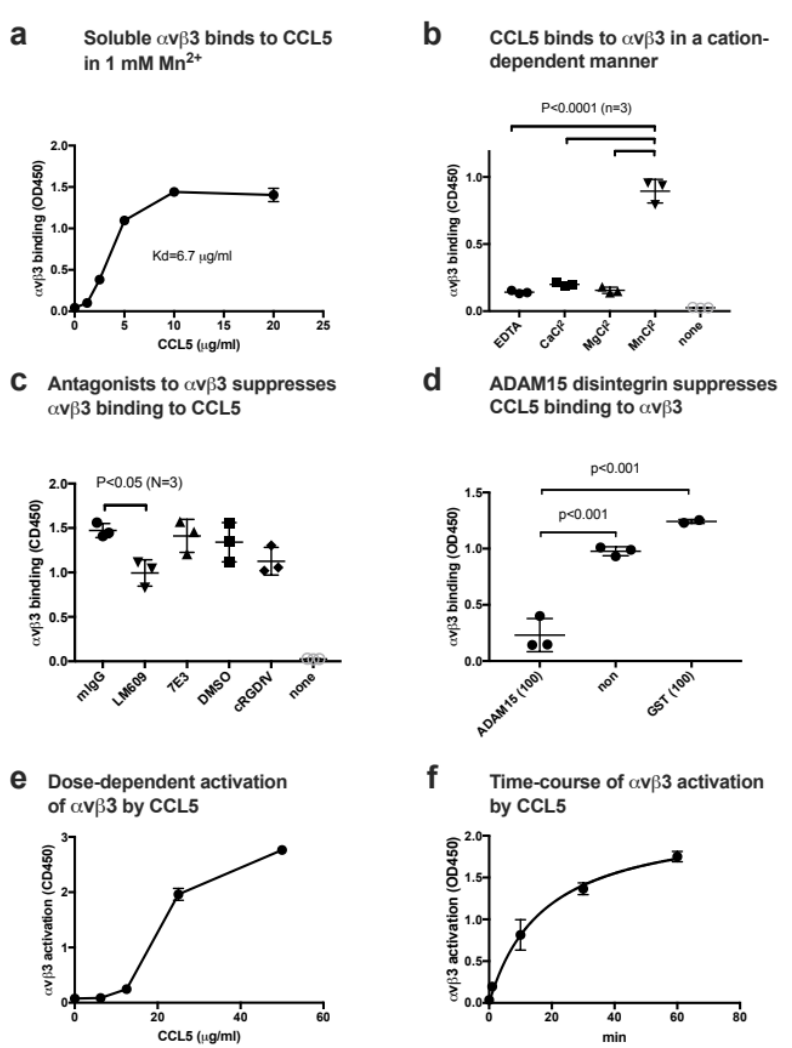
Figure 2. CCL5 binds to and activates integrin αvβ3. ( a ) Binding of soluble integrin αvβ3 to CCL5 in 1 mM Mn 2+ in cell-free conditions. Wells of 96-well microtiter plates were coated with CCL5 and remaining protein- binding sites were blocked with BSA. Wells were incubated with soluble αvβ3 (1 μg/mL) in Tyrode -HEPES buffer with 1 mM Mn 2+ (to activate αvβ3) for 1 h at room temperature. After washing the wells to remove unbound integrin, bound αvβ3 was quantifie d using anti- β3 mAb (AV10) and HRP- conjugated anti mouse IgG. Data are shown as means +/− SD in triplicate experiments. ( b ) Cation dependency of αvβ3 binding to CCL5. Binding of soluble integrin αvβ3 to CCL5 was measured in the presence of different cations (1 mM) in ELISA-type binding assays. Data are shown as means +/− SD in triplicate experiments. ( c ) Effect of antagonists to αvβ3 on CCL5 bind- ing to αvβ3. The concentrations of antagonists used are 10 μg/mL for LM609 and 7E3, and 10 μM for cRGDfV. Data ar e shown as means +/− SD in triplicate experiments. ( d ) ADAM15 disintegrin, a specific ligand for αvβ3, suppresses CCL5 binding to αvβ3. ADAM15 disintegrin fused to GST or control GST (100 µg/mL each) were included in the binding assay as described in (a). Data are shown as means +/− SD in triplicate experiments. ( e ) Activation of soluble αvβ3 by CCL5 in 1 mM Ca 2+ . Wells of 96- well microtiter plates were coated with γC399tr, a specific αvβ3 - ligand (20 μg/mL) and remaining protein-binding sites were blocked w ith BSA. Wells were incubated with soluble αvβ3 (1 μg/mL) in Tyrode -HEPES buffer with 1 mM Ca 2+ for 1 h at room temperature in the presence of CCL5. After removing the unbound integrin, bound αvβ3 was quantified using anti - β3 mAb (AV10) and HRP-conjugated anti mouse IgG. Data are shown as means +/− SD in triplicate experiments. ( f ) Time- course of activation of soluble αvβ3 by CCL5. Wells of 96 -well microtiter plates were coated with γC399tr (a specific ligand for αvβ3) (20 μg/mL) and remaining protein -binding sites were blocked with BSA. Wells were incubated with soluble αvβ3 (1 μg/mL) and CCL5 (20 μg/mL) at room temperature in Tyrode-HEPES buffer with 1 mM Ca 2+ for the time indicated. After washing the wells